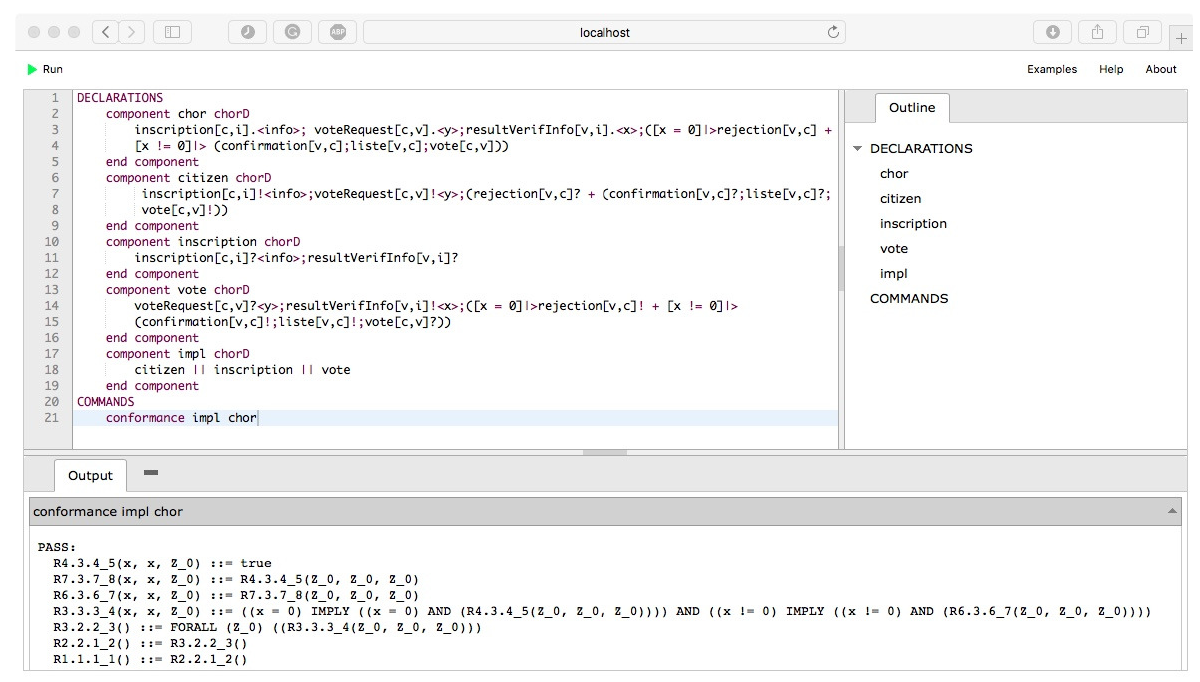
Figure 11. Conformance checking.